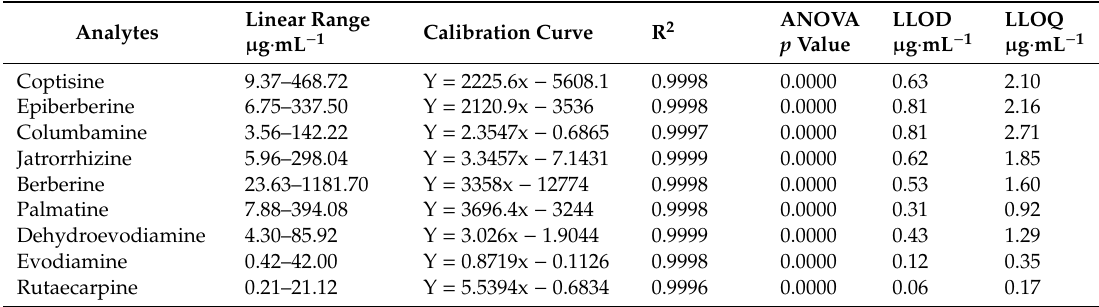
Table 2. The regression equations of nine